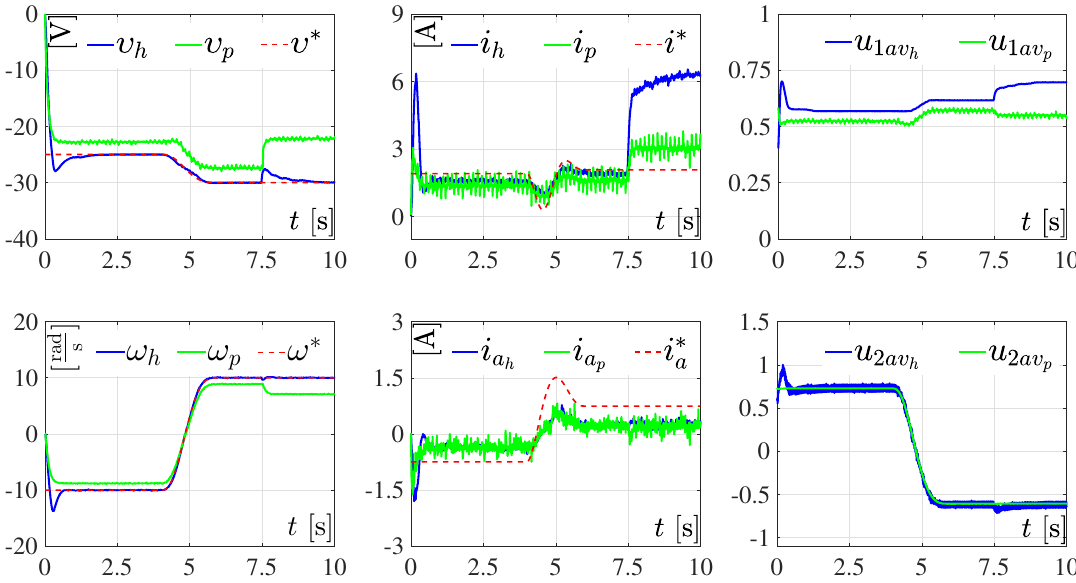
Figure 5. Experimental results in closed-loop when variations in R are considered. The results associated with the hierarchical controller correspond to the graphics denoted by υ h , i h , u 1 av and u 2 av , while the results related to the passive controller are labeled as υ p , i p , u 1 av h u 2 av p